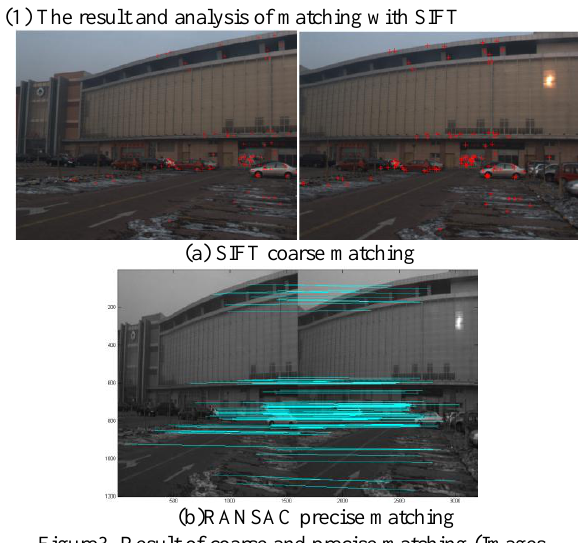
Figure3. Result of coarse and precise matching (Images 70#,71#)